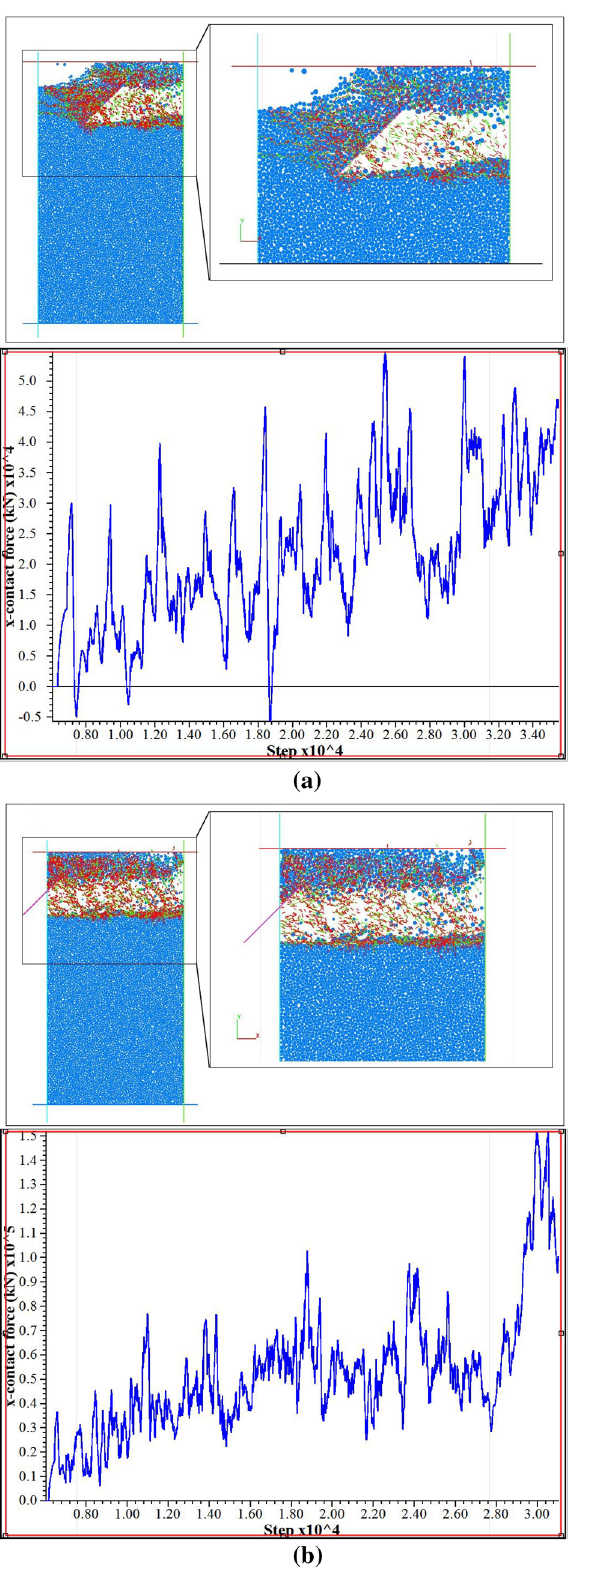
Fig. 14 Results of plow model with zero-degree angle: a Model 15, b Model